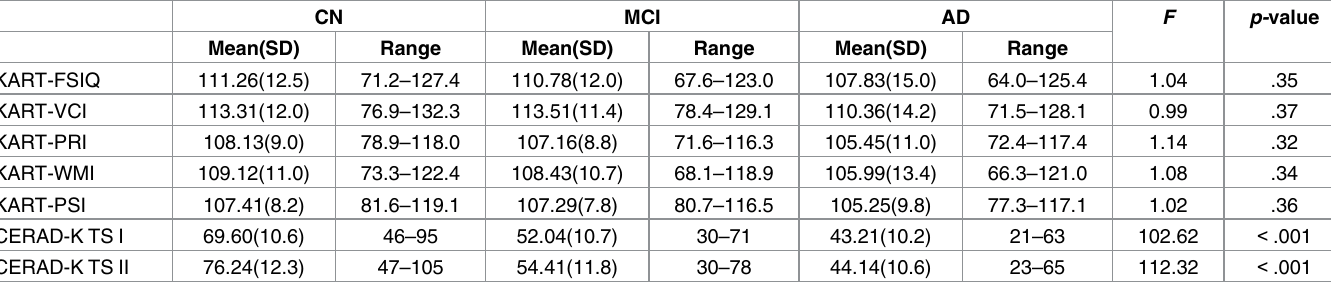
Table 4. Differencesof CERAD-Ktotal score (TS) and KART-predicted IQs between the